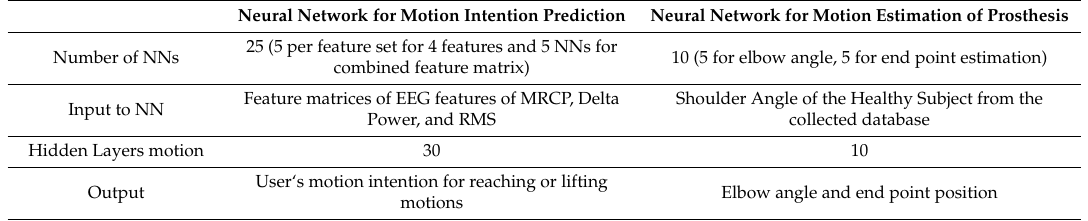
Table 2. Summary of configuration of proposed Neural Networks